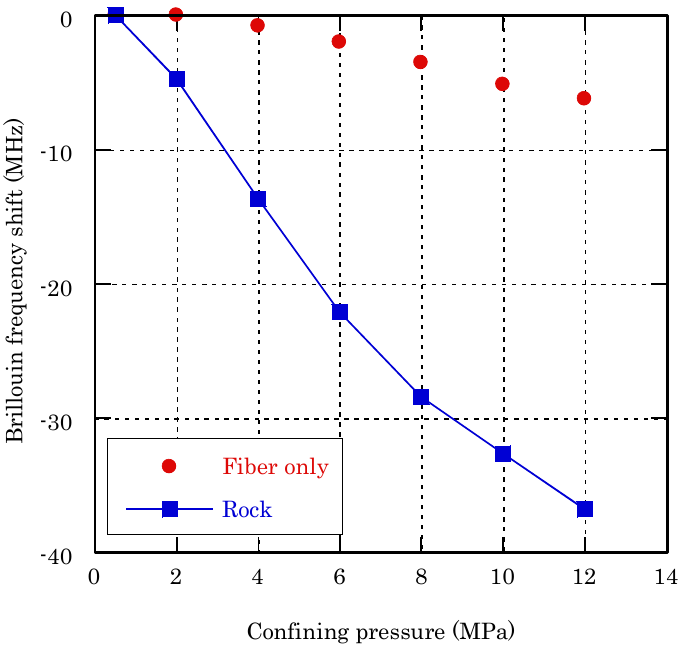
Figure 8. The mean value of Brillouin frequency shift measurements at the 11 censoring points with increasing confining pressure; in comparison with the baseline value (sensor region B) for Berea core.